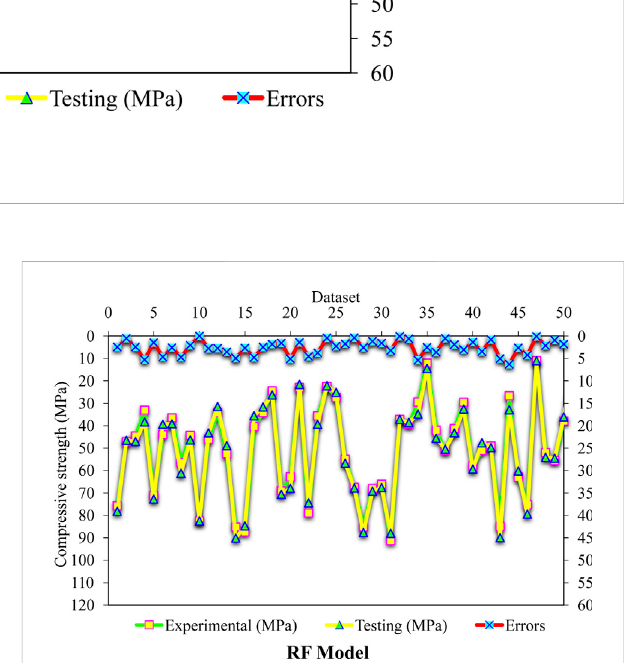
FIGURE 15 RF estimated and experimental values distribution with